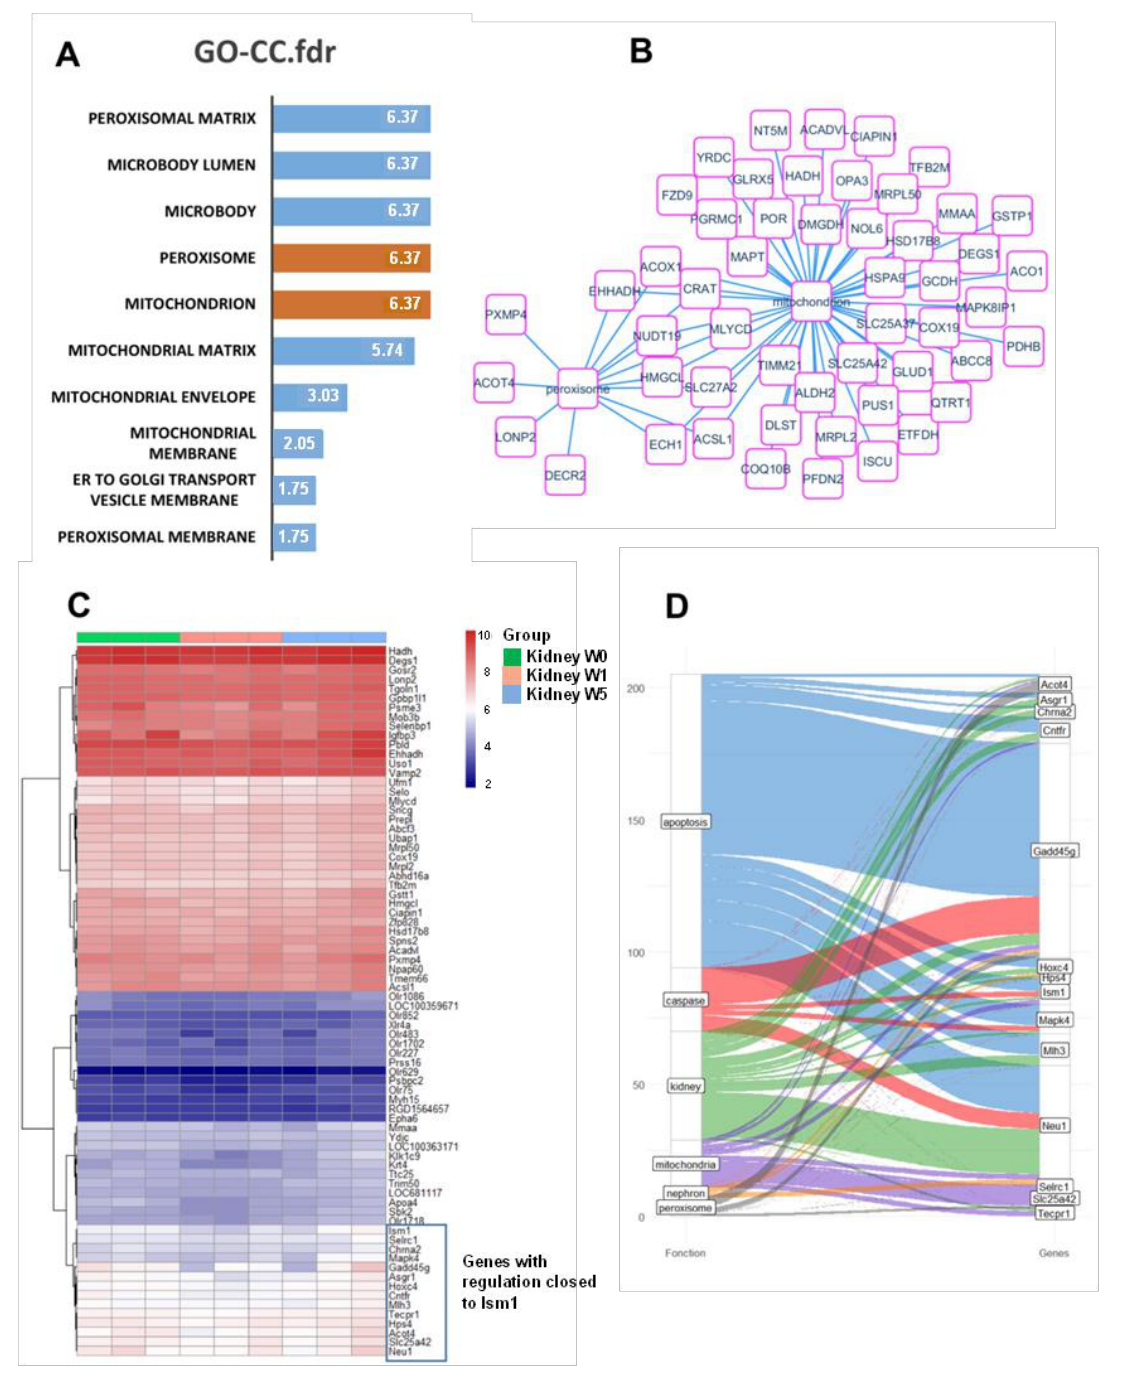
Figure 7. Mitochondria and peroxisome regulation during ISM1 time course model during kidney regeneration. ( A ) Functional enrichment on gene ontology cellular component database of genes found correlated to ISM1 during kidney regeneration (fdr: false discovery rate): barplot of negative log10 FDR adjust p -values; ( B ) Functional enrichment network performed with mitochondria and peroxisome related genes found correlated to ISM1; ( C ) Expression heatmap of best 75 genes found correlated to ISM1 expression kidney regeneration: blue gene cluster defined genes with regulation closed to ISM1; ( D ) Alluvial plot built on gene-function found in NCBI database with genes highlighted closely regulated with ISM1 during kidney regeneration (quantitative colored links represent the numbers of NCBI-Pubmed articles connected).